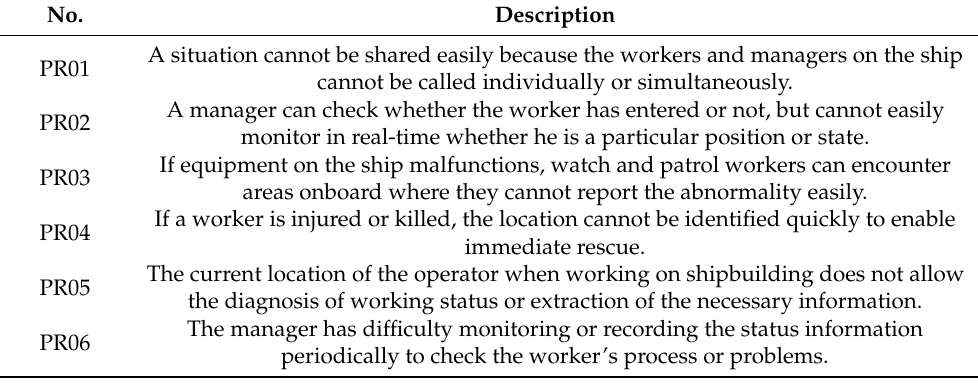
Table 1. Problems of the ILMS